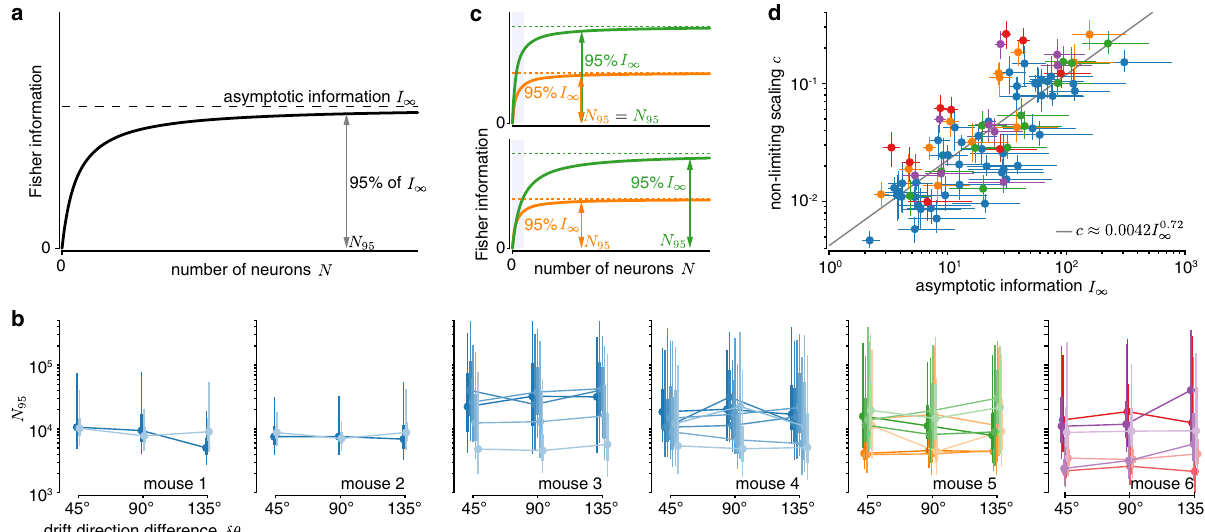
Fig. 7 Tens of thousands of neurons are required to capture most of the information about stimulus drift direction. a The TILC predicts how information grows with population size and allows us to estimate the population size N 95 required to capture 95% of the asymptotic information I ∞ . b Applied to our data, we fi nd N 95 in the order of tens of thousands of neurons, consistently across mice (panels) and sessions (colors; blue = uniform contrasts; orange/ red = low contrast; green/magenta = high contrast; lines connect individual sessions; horizontally shifted to ease comparison; posterior densities as is Fig. 4c). c An increase in information (orange to green) could be achieved by increasing the average information per neuron (top) or by leaving the average information per neuron roughly unchanged while recruiting more neurons (bottom). We would expect N 95 to grow in the second, but not the fi rst case. These two cases are hard to distinguish from the observed information scaling in smaller populations (shaded blue). d Plotting estimated non-limiting scaling c over asymptotic information I ∞ (dot = median, lines = 50% credible interval; colors as in panel b ) for all animals, sessions, drift direction differences, and contrasts from b reveals that c grows sub-linearly with I ∞ (gray line = linear regression of median estimates in log – log plot), which indicates that the estimated population size N 95 increases weakly with the asymptotic